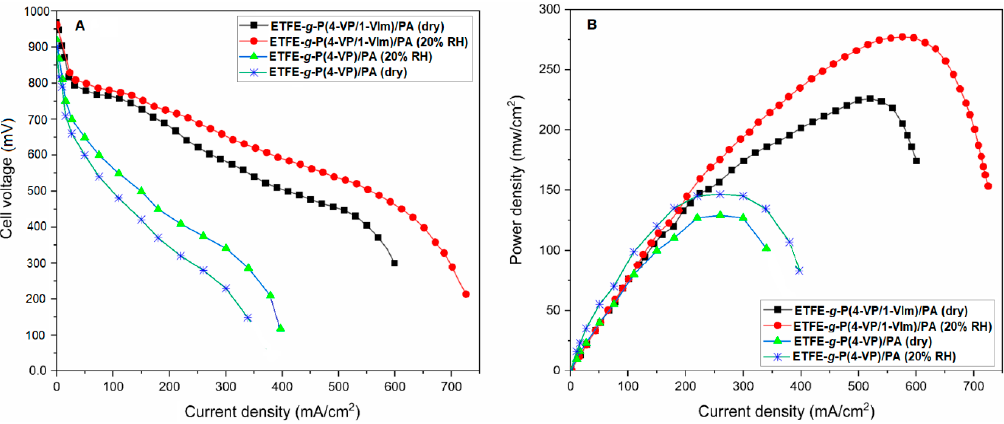
Figure 15. Performance of HT-PEMFC single cell with PA doped membranes (DG = 59% with a doping level of 119%): ( A ) polarization curves and ( B ) power density curves, tested under an anhydrous condition and 20% RH. H 2 flow rate of 450 mL/min and that of O 2 is 300 mL/min at temp. of 120 °C.